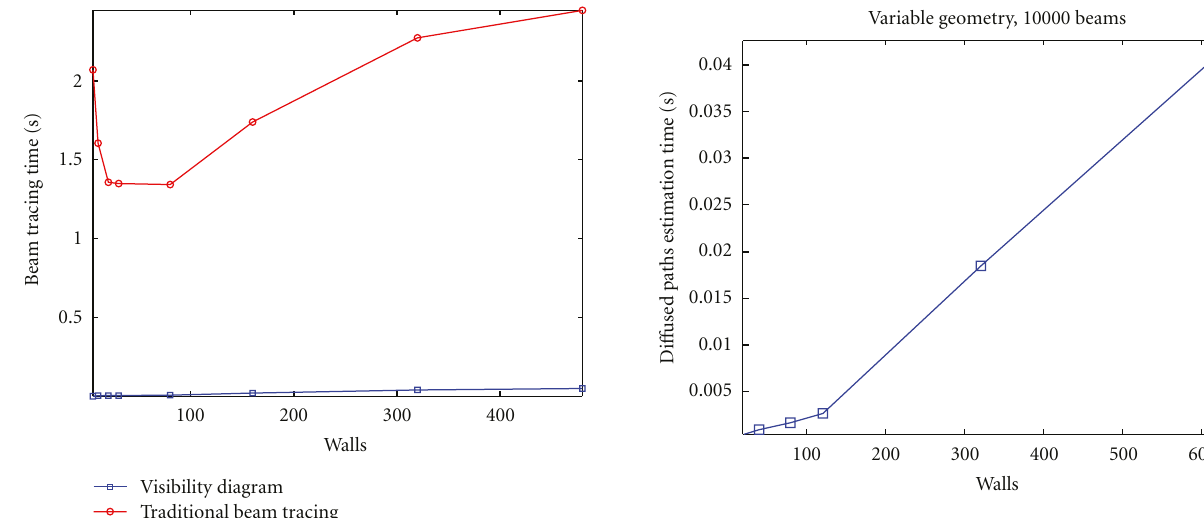
Figure 15: Tracing time of the di ff usive paths as a function of the number of walls of the environment of Figure 13.